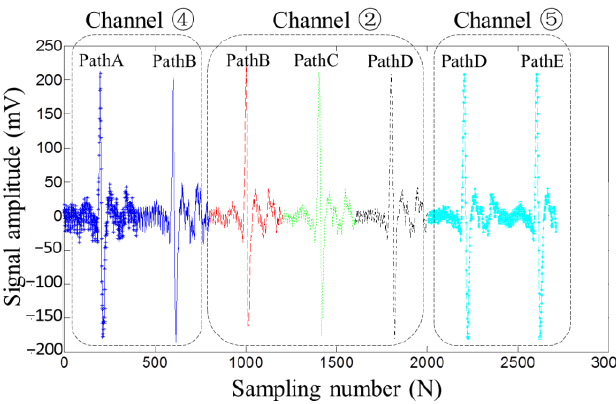
Figure 11. The MFL signals picked up by array lift-off-tolerant MFL sensors in different scanning paths.